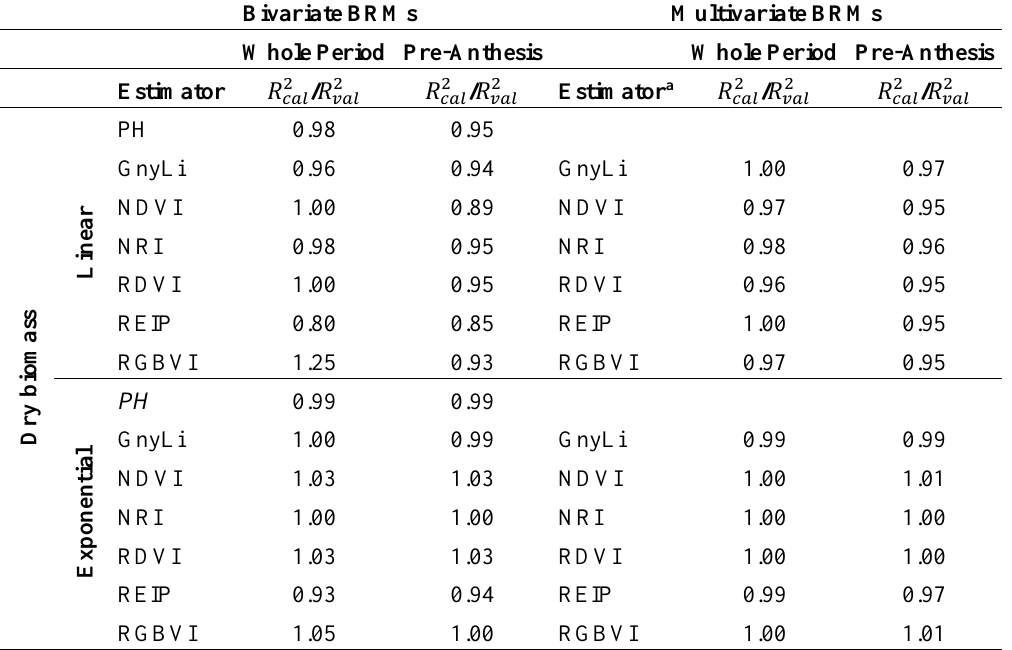
Table A2. Ratio between model calibration and validation ( 𝑅 𝑐𝑎𝑙2 : coefficient of determination from calibration; 𝑅 𝑣𝑎𝑙2 : coefficient of determination from